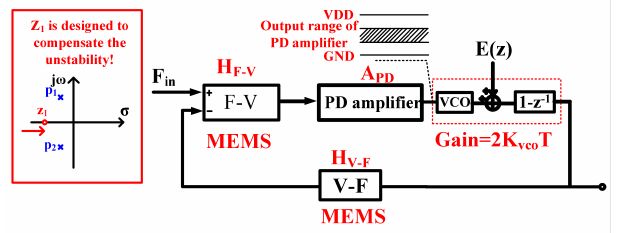
Figure 4. Principle of the force translating